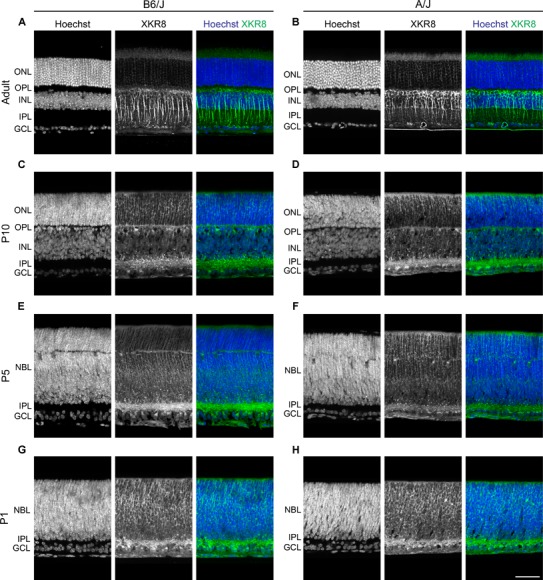
(A,B) Strain comparison of XKR8 immunofluorescence in the mature retina, showing a comparable pattern of bipolar cell labeling in B6/J (left) and A/J (right) retinal sections. (C,D) At P10, labeling of newly differentiating bipolar cells was detected, as well as labeling in the ONL and amongst amacrine and ganglion cells and their processes in the IPL. (E–H) At P5 and P1, labeling was present in the inner retina and within the neuroblast layer. Scale bar = 50 μm.